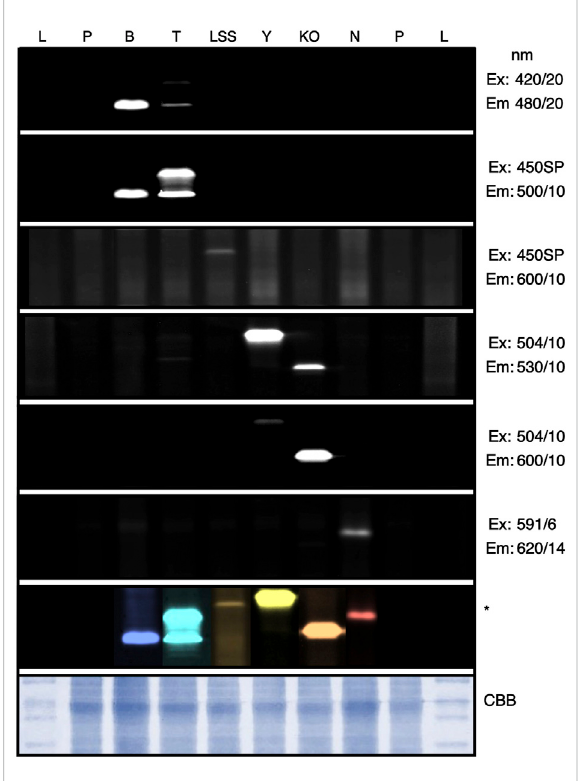
FIGURE 3 In-gel fl uorescence screening of reporter protein signals.